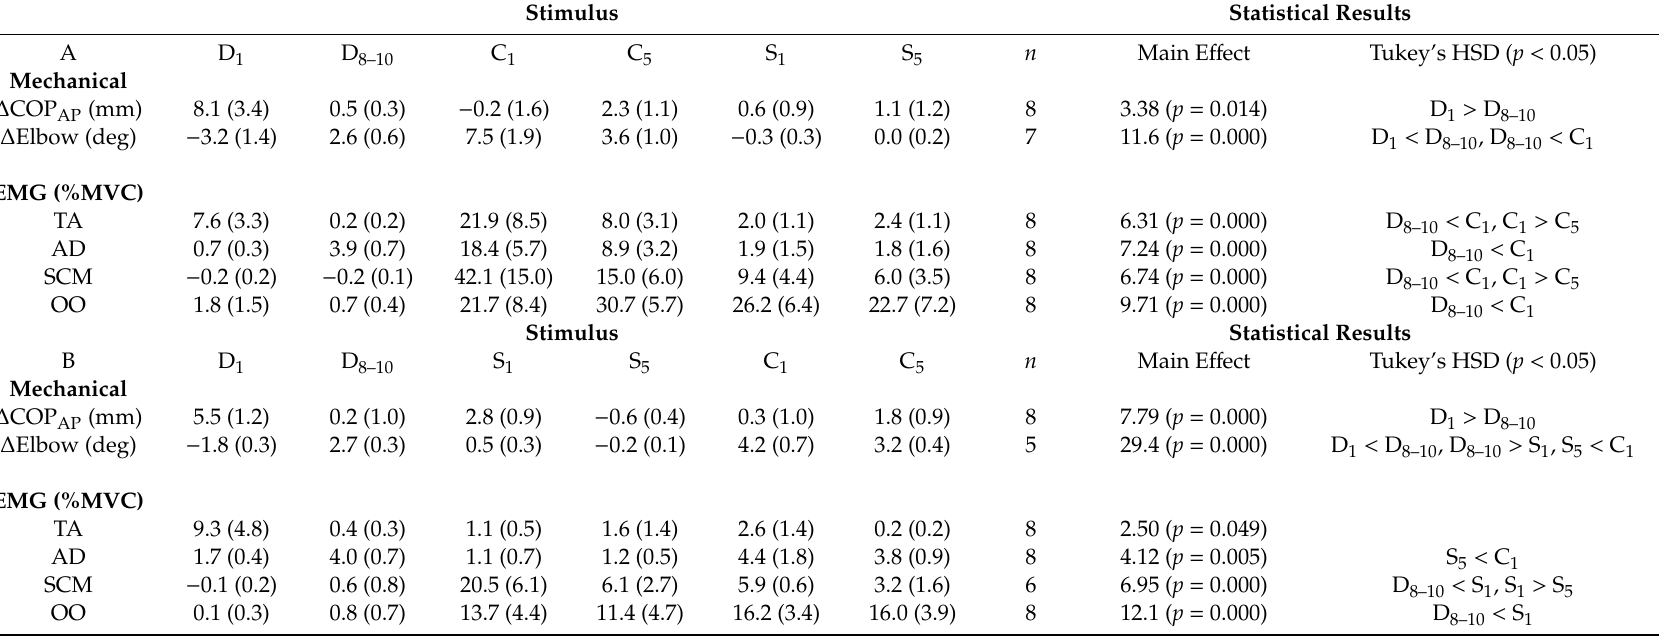
Table 1. Change in COP AP position and elbow angle, and normalized muscle response